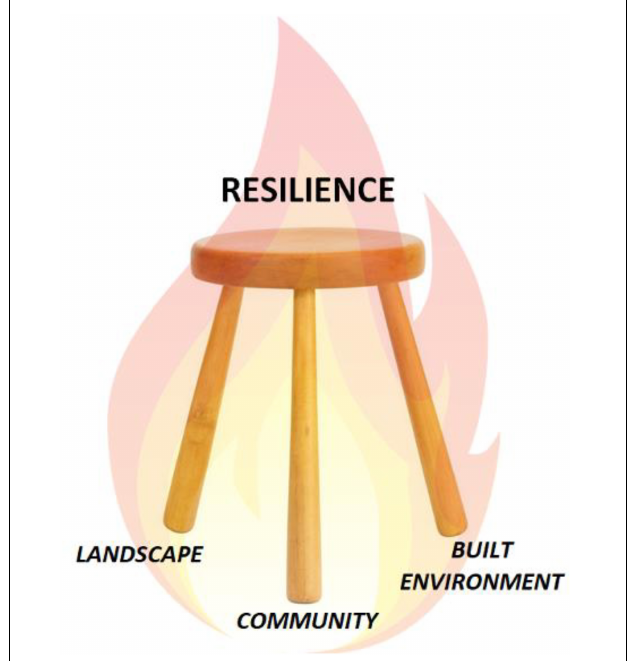
FIGURE 2 | Wildland–urban interface (WUI) Resilience is dependent on risk mitigation in multiple domains, each with its own opportunities and